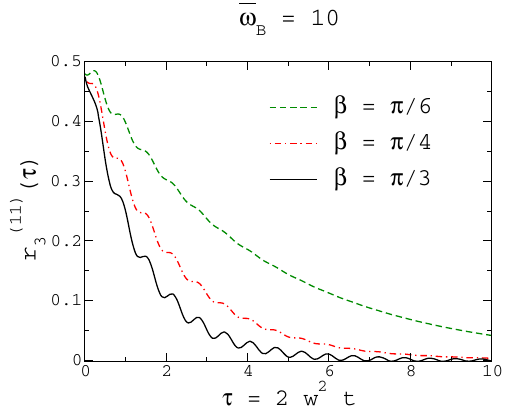
Fig. 6 Time dependence of the density-matrix component r ( 11 ) reduced frequency ¯ ω = μ ν B / 2 w 2 = 10 and three different values of the angular parameter β . The initial conditions are the same as in Fig. 5